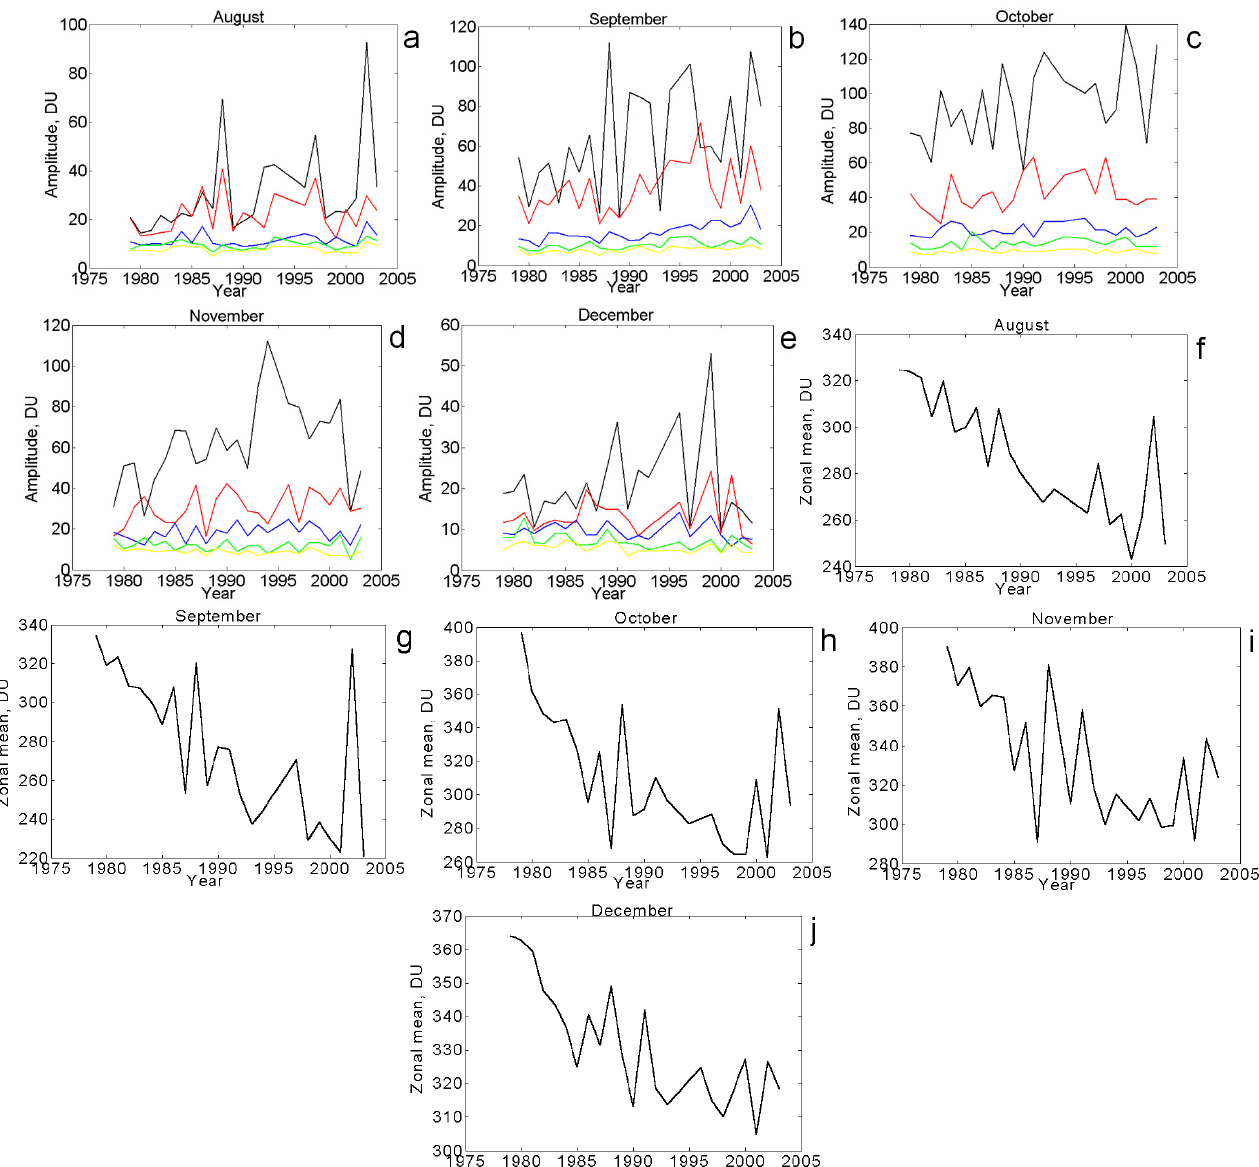
Fig. 4. Interannual variations of the monthly mean amplitude of the wave numbers 1–5 for August-December (a–e) and zonal mean total ozone at 65 ◦ S (f–j) for the same months. Colors are black (wave 1), red (wave 2), blue (wave 3), green (wave 4) and yellow (wave